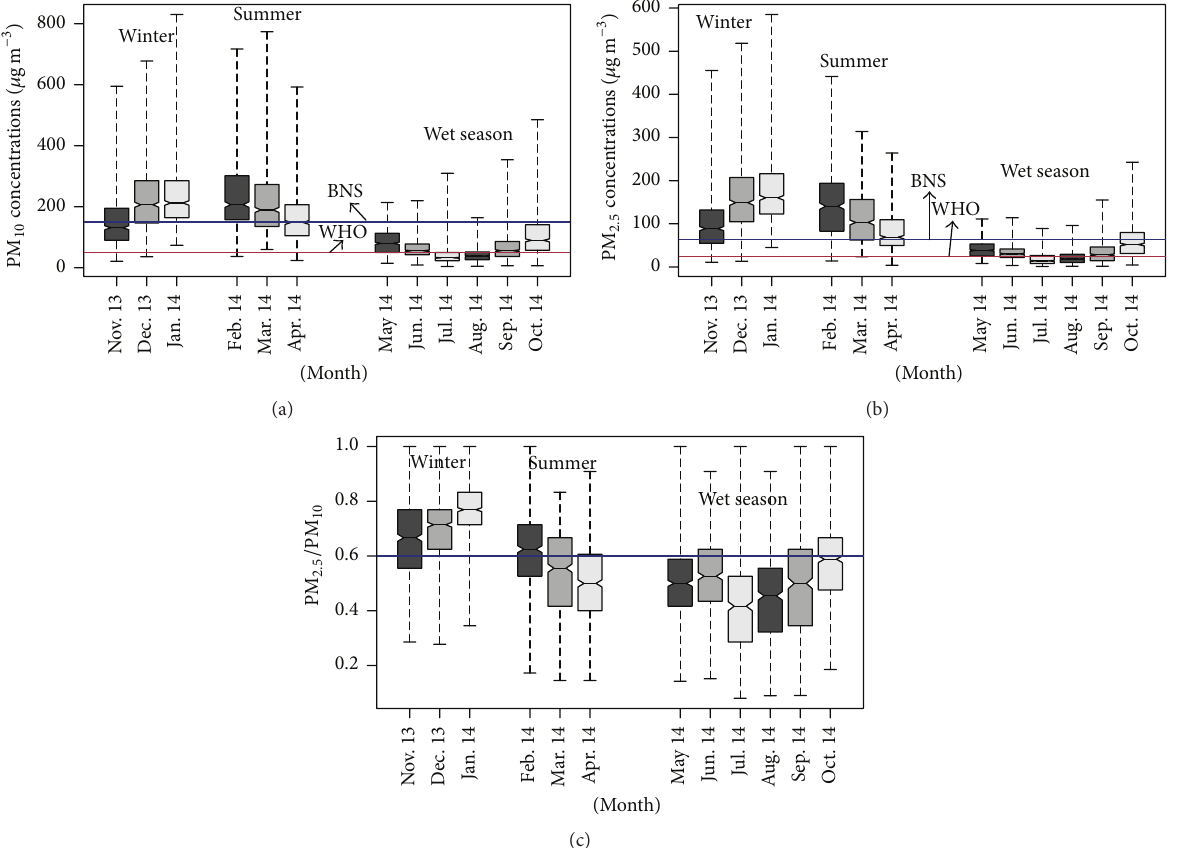
Figure 2: Box-Whisker plots of (a) PM 10 concentrations, (b) PM 2.5 concentrations, and (c) PM 2.5 to PM 10 ratio plotted using hourly concentration data and shown for different months from November 2013 to October 2014 in Gazipur; BNS: Bangladesh National Standard and WHO: World Health Organization guideline value for 24-hour average